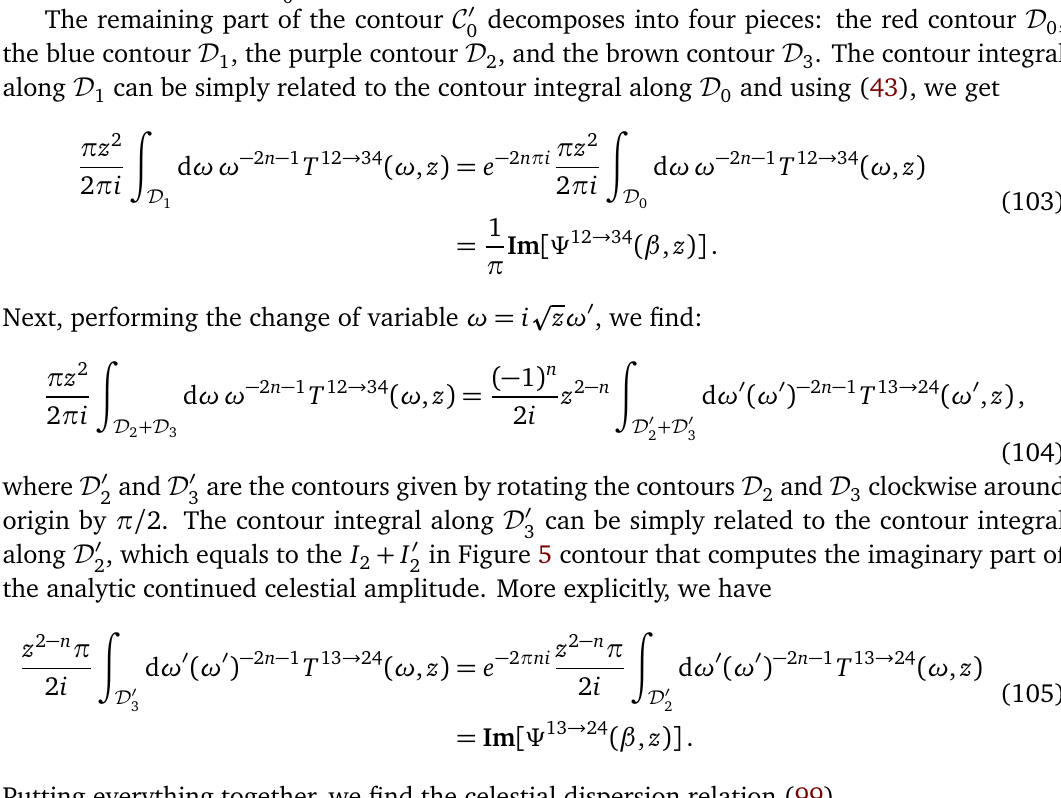
Figure 6: Left: The contour C ( −∞ further decomposes into the red contour D D , the brown contour D 2